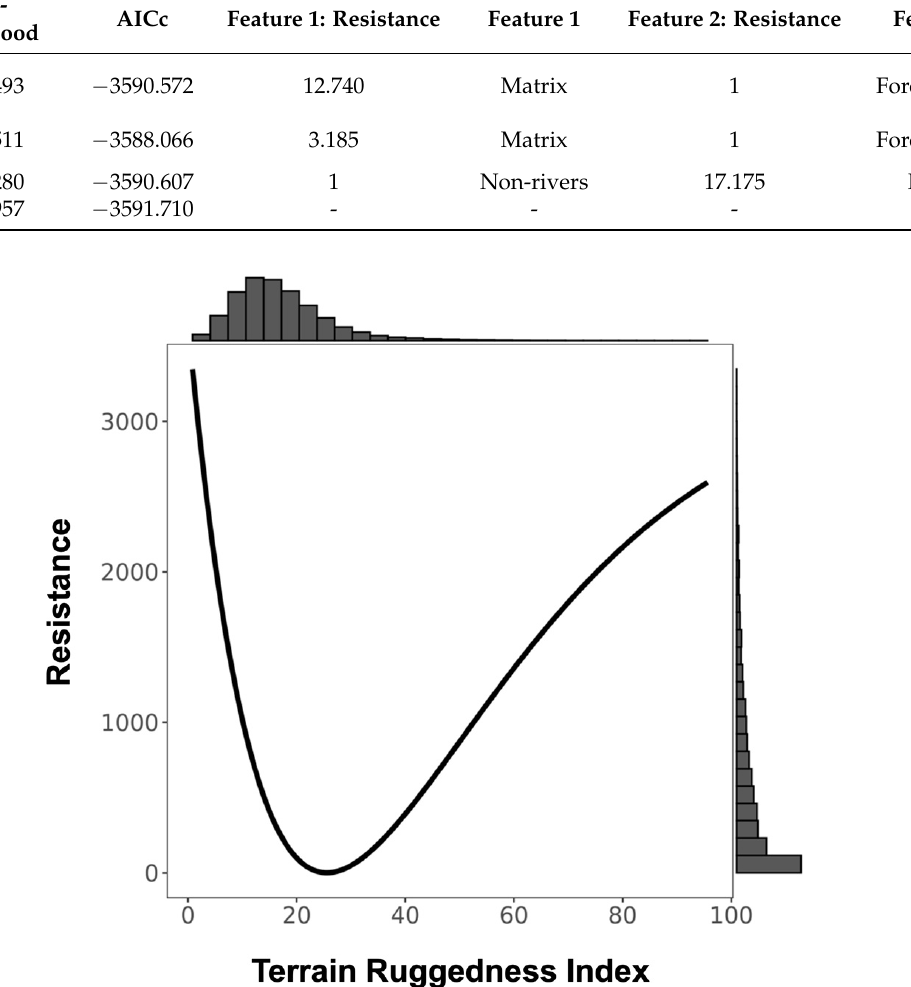
Figure 3. Resistance transformation plot for single surface Terrain Ruggedness Index (TRI). Low TRI values represent relatively flat terrain and high values represent rugged areas. Resistance to ruffed lemur movement was greater in flat (low value) and rugged (high value) terrain.